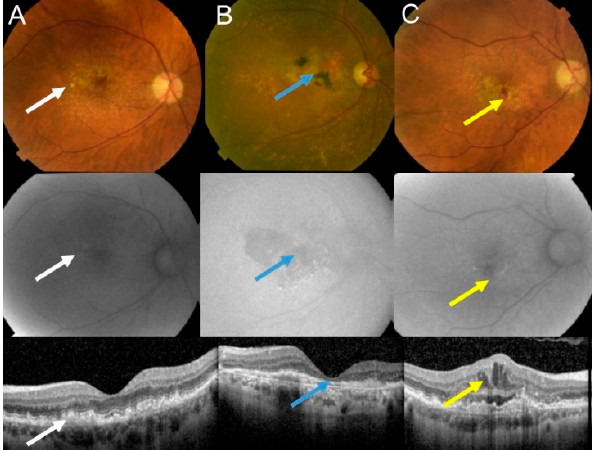
Figure 1. Age-related macular degeneration (AMD) may basically occur in two forms: dry and wet. Fundus photograph (upper panel), autofluorescence (middle panel), and optical coherence of intermediate dry AMD with drusen (white arrows) ( A ); advanced geographic atrophy (GA) with typical GA lesions (blue arrows) ( B ); and wet AMD with subretinal and intraretinal fluids and hemorrhage (yellow arrows) ( C ) .